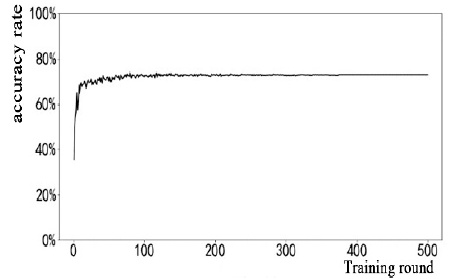
Figure 19. Expert-driven learning with a factor of ½.